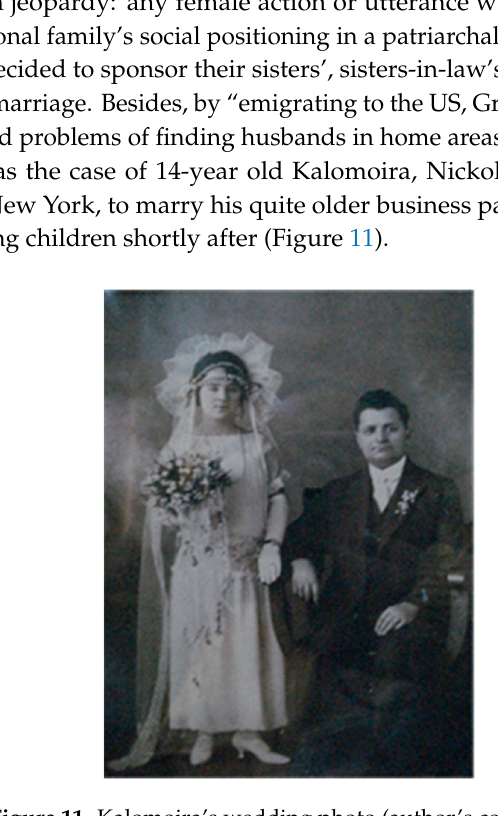
Figure 11. Kalomoira’s wedding photo (author’s collection).